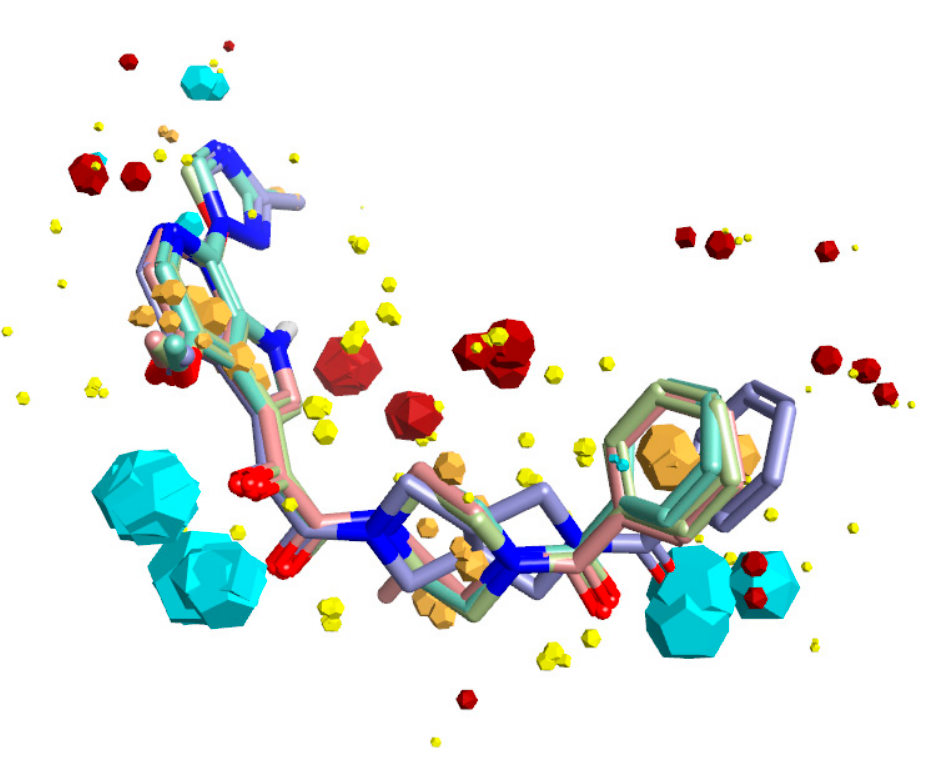
Figure 1. Bioactive conformation hypothesis and field-point pharmacophore of BMS-377806, BMS-488043, BMS-626529, and SC11. Blue field points = negatively charged; red = positively charged. Yellow spheres = van der Waals; gold = hydrophobic. Oxygen atoms are shown in red, nitrogen in blue. The size of the field point is directly related to the strength of the interaction.